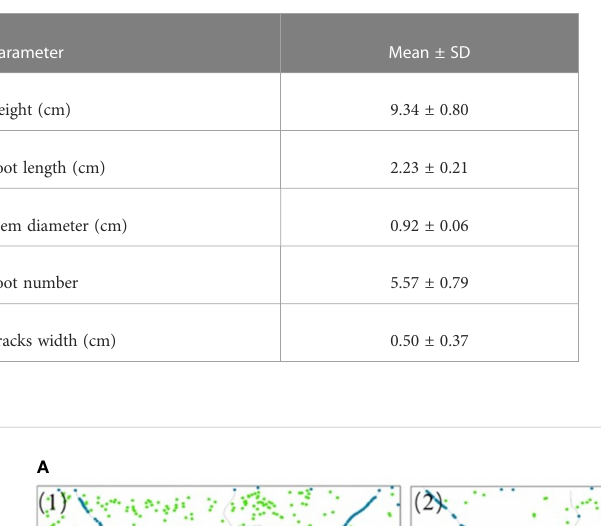
TABLE 2 Properties of plants and mud cracks.